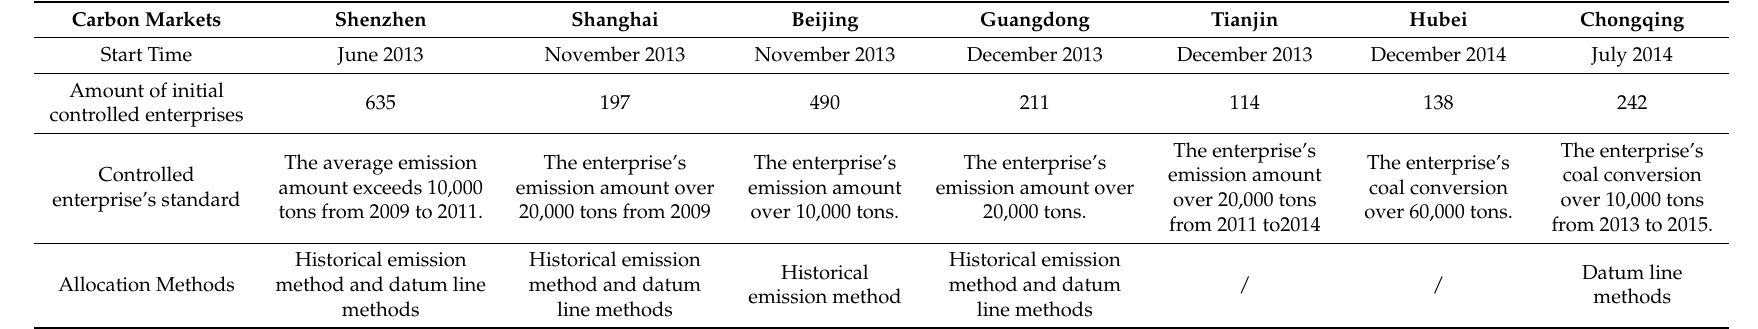
Table 3. Basic information about the carbon markets and the admission